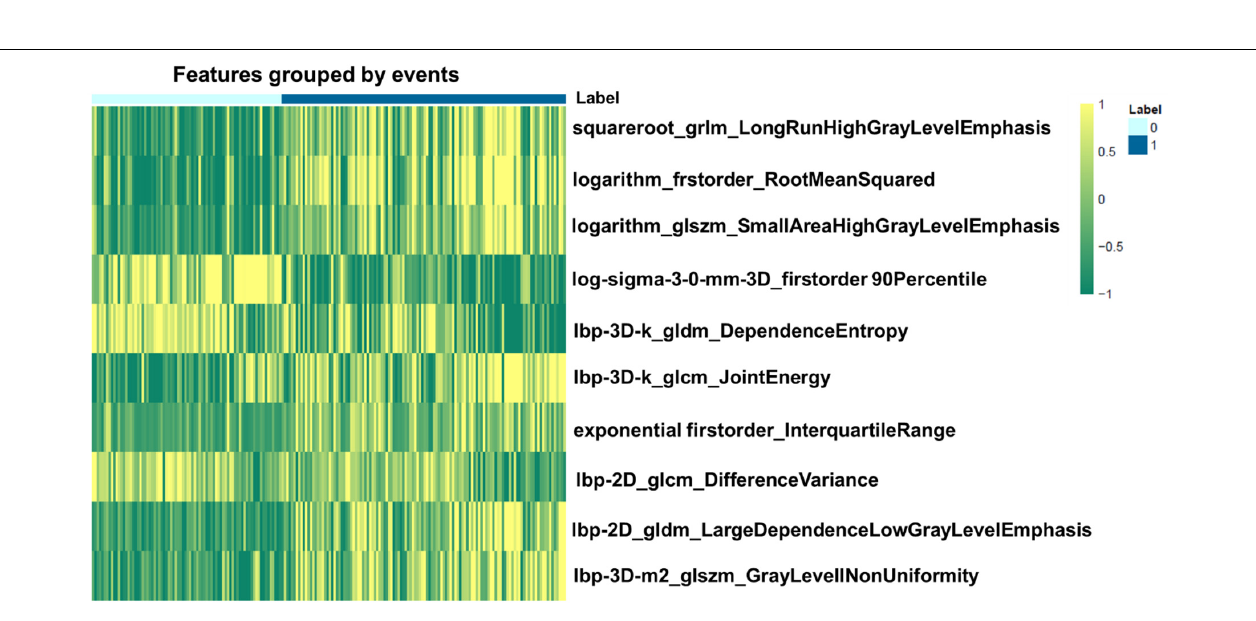
Frontiers in Cardiovascular Medicine |